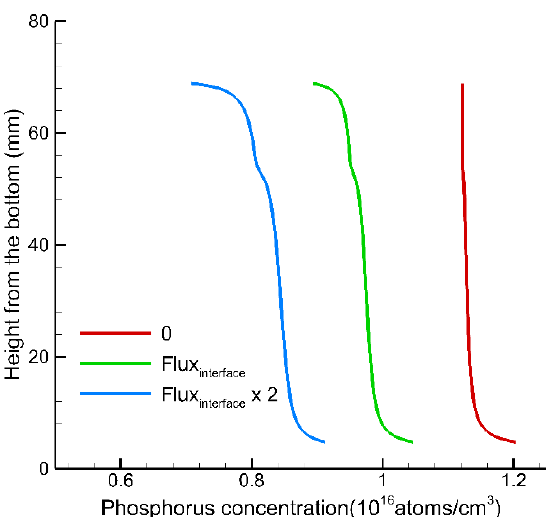
Figure 10. Distribution of the phosphorus concentration in the center of the melt along the vertical direction with different evaporation fluxes at the melt surface three hours after the start of solidification. The phosphorus evaporation flux at the melt surface was (i) 0, (ii) the same as the phosphorus incorporation flux at the melt–crystal interface, and (iii) twice as large as that of case (ii).